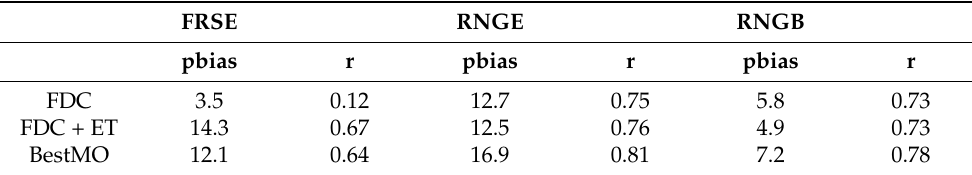
Table 3. Performance metrics for the simulated evapotranspiration during the validation period (2008–2009). Legend: FRSE = evergreen forest; RNGE = savanna grassland; RNGB = shrubland. FRSE